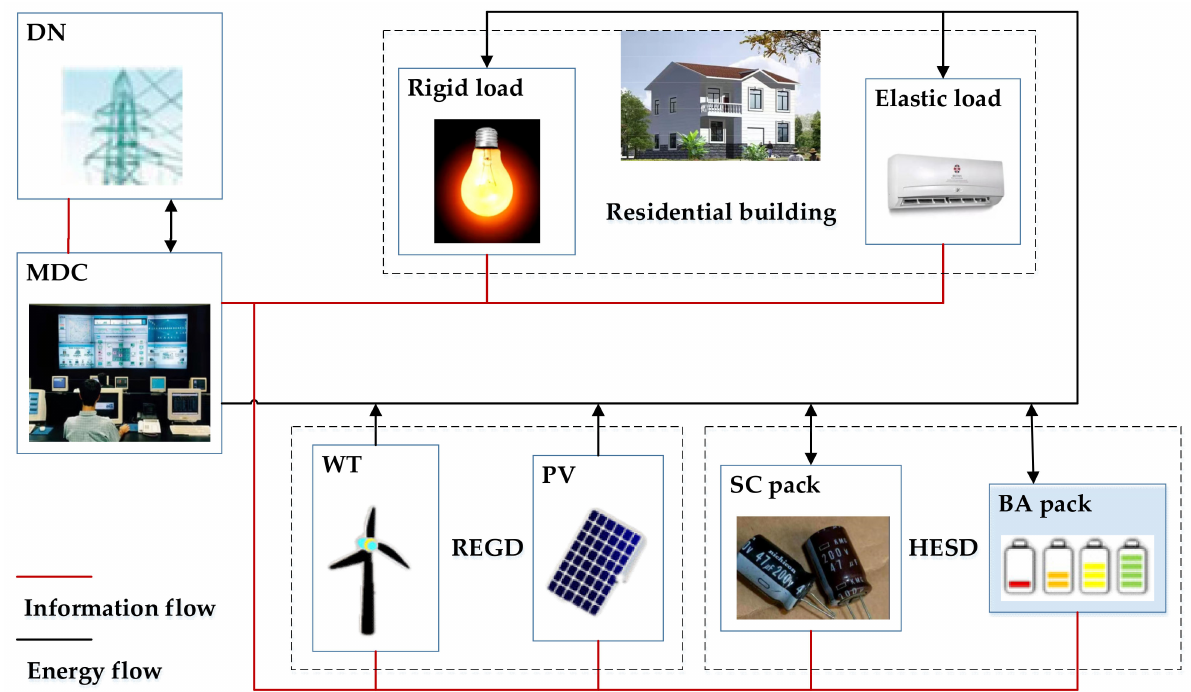
Figure 1. The basic framework of a microgrid district under the Guizhou Power